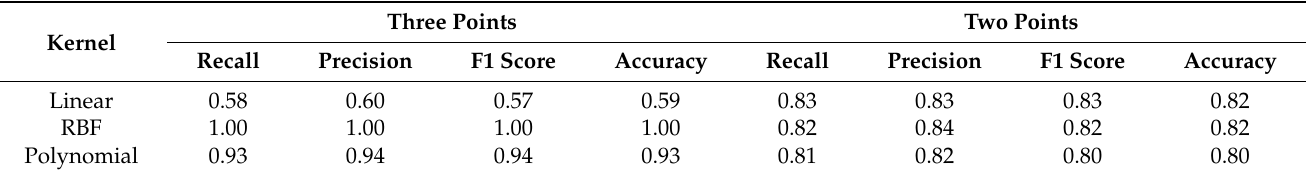
Table 2. Experiment with SVM Method.